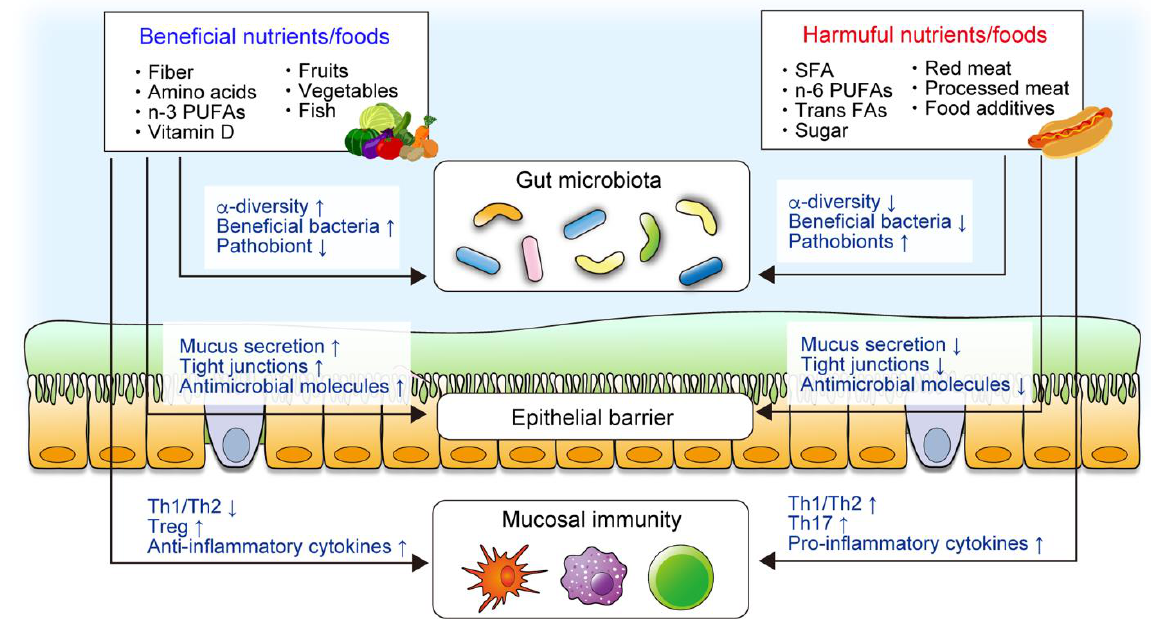
Figure 1. The roles of nutrients and foods in the pathogenesis of inflammatory bowel disease (IBD). Epidemiological, clinical, and animal studies have demonstrated that certain components of diet are associated with IBD. Diet plays a critical role in intestinal homeostasis, including the gut microbiota, intestinal mucosal barrier, and mucosal immune system. Diet directly modulates the mucosal barrier and immunity, whereas diet–microbiota interaction also regulates the intestinal homeostasis.